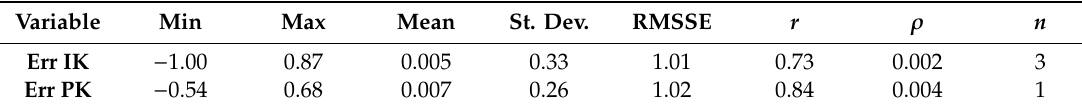
Table 4. Results of cross-validation test for the procedures indicator kriging (Err IK) and probability kriging (Err PK). RMSSE is the root mean squared standardized error; r is the correlation coe ffi cient between observation and estimation; ρ is the correlation coe ffi cient between standardized error and estimation; n is the number of